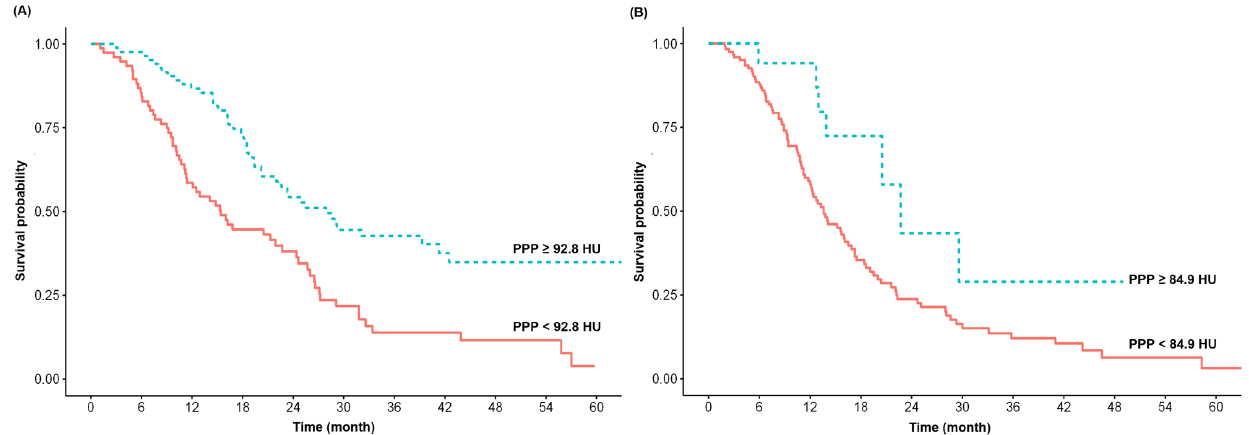
Figure 3. Kaplan–Meier curves showing the relationship between radiologic parameters and overall survival. ( A ) Contrast enhancement during the pancreatic parenchymal phase (PPP) and overall survival (OS) in patients with resectable pancreatic cancer. ( B ) Contrast enhancement during the PPP and OS in patients with borderline resectable or locally advanced pancreatic cancer.